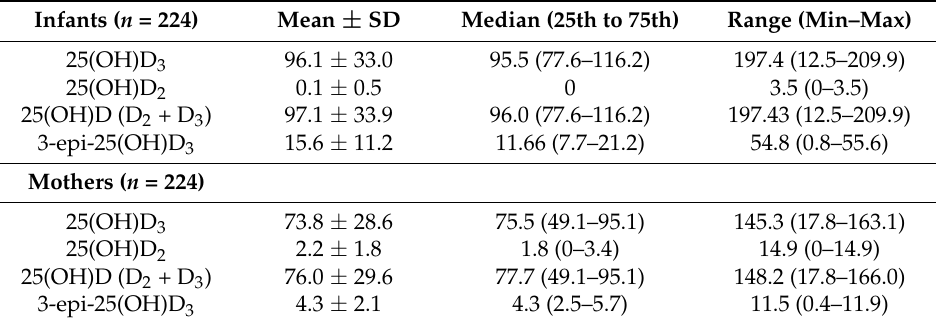
Table 2. Vitamin D status (nmol/L) of infants and mothers.